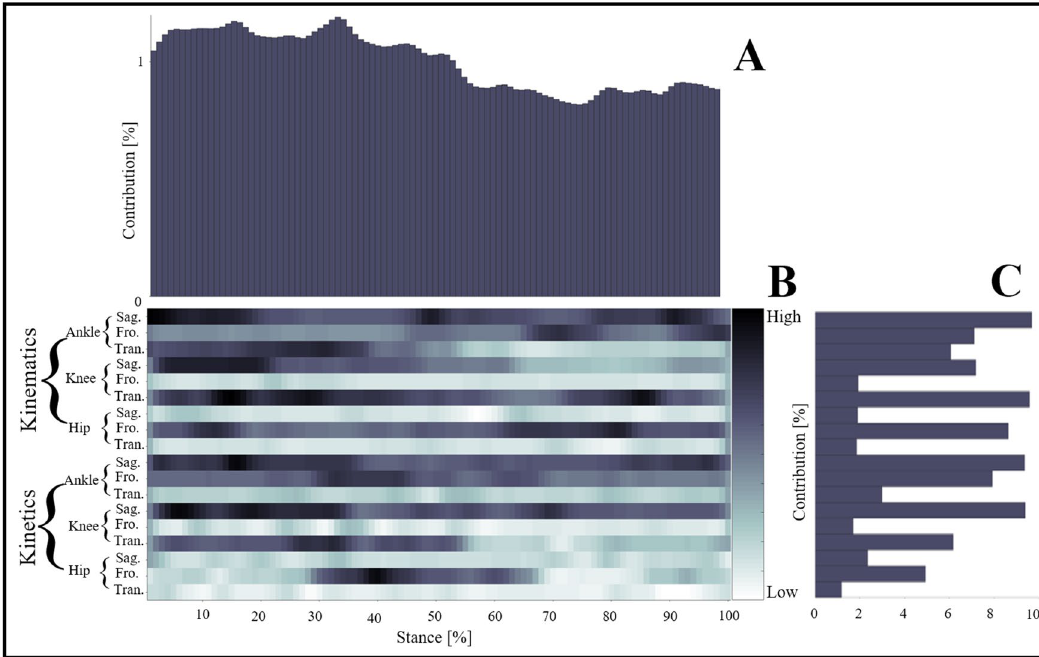
Figure 2. The LPR results in the average absolute relevance score of every variable in a stride pattern. ( A ) The relative contribution of variables during the overall stance phase (0%–100%). ( B ) The detailed distribution of relevance score during each joint (ankle, knee, hip) of each plane (sagittal, frontal, transverse) of kinematics (joint angle) and kinetics (joint moment). The darker colors mean high relevance variables, the lighter colors mean low relevance variables. The model relied more on darker color variables; the lighter colors variables had less relevance with correctly classified gait patterns. ( C ) The summed contribution of the relevance score of each joint (ankle, knee, hip) of each plane (sagittal, frontal, transverse) of kinematics (joint angle) and kinetics (joint moment) trajectories.